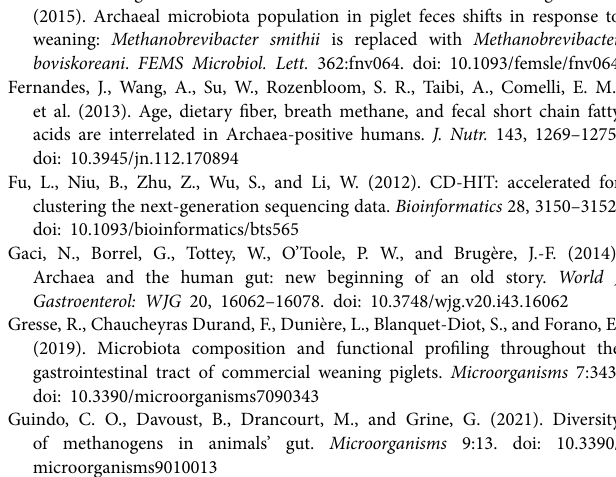
SUPPLEMENTARY FIGURE S1 | Longitudinal changes of archaeal community diversity and structure in the swine gut with age. Archaeal diversity within samples were measured by Observed species (A) and Shannon index (B) . Value of p based on Kruskal–Wallis (pairwise) tests for Observed species and Shannon index are shown for each neighboring pairwise comparison. The principal coordinate analysis (PCoA) plots based on Jaccard (C) and Bray–Curtis (D) distance show between-group differences. Different color/shape represent sampling time points from day 7 to day 140. SUPPLEMENTARY FIGURE S2 | Total relative abundances of archaeal reads of the three weaning groups at different growth stages. SUPPLEMENTARY FIGURE S3 | Dynamic changes of the top three archaea species over time in the different weaning groups. Y -axes represent the relative abundance of archaea. (A) All samples, (B) samples weaning on day 14, (C) samples weaning on day 21, (D) samples weaning on day 28. SUPPLEMENTARY FIGURE S4 | Longitudinal changes of archaeal KEGG KOs diversity and structure in the swine gut. Archaeal diversity within samples were measured by Observed KEGG KOs (A) and Shannon index (B) . The principal coordinate analysis (PCoA) plots based on Jaccard (C) and Bray–Curtis (D) distance show between-group differences. Different colors represent sampling time points from day 7 to 140. SUPPLEMENTARY FIGURE S5 | Scatter plots illustrating the association between bodyweight and the four important predictors identified by LefSe analysis. (A) Observed species, (B) Methanobrevibacter A sp900769095 , (C) Methanobrevibacter A smithii , and (D) Methanobrevibacter ruminantium A. For archaeal species (B–D) , y -axis represents relative abundance of archaeal species. Pearson’s correlation coefficient ( R ) and Pearson’s correlation test p -value are labeled on each plot. SUPPLEMENTARY FIGURE S6 | Bodyweight gain-related archaeal species during growing and finishing stages. The most important bodyweight gain-related archaeal species during finishing stage (A) , from day 70 to 140) were identified using the random forest regression algorithm in R. Scatter plots shown the relationship between bodyweight gain and Methanobrevibacter A sp900319535 (B) , and Methanobrevibacter A smithii (C) . The y -axis represents changes of relative abundance of archaeal species, x-axis represents bodyweight gain of pigs from day 70 to